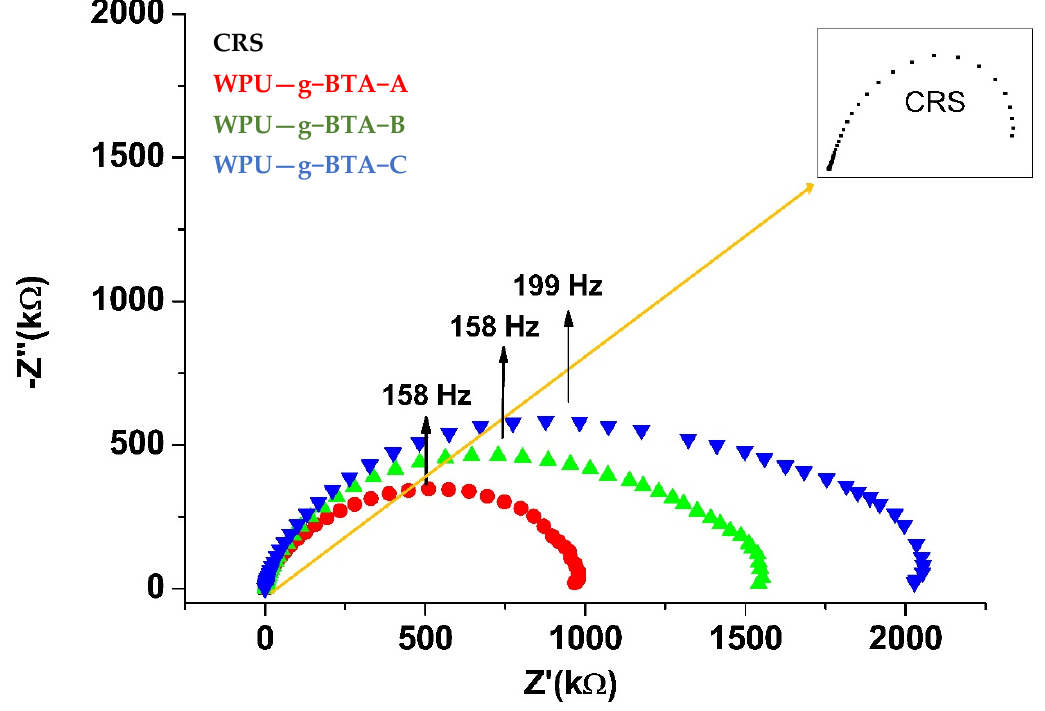
Figure 7. Nyquist plots for raw CRS electrode and CRS electrode coated with WPU − g − BTA − A, WPU − g − BTA − B, WPU − g − BTA − C in 3.5 wt% NaCl (aq) .